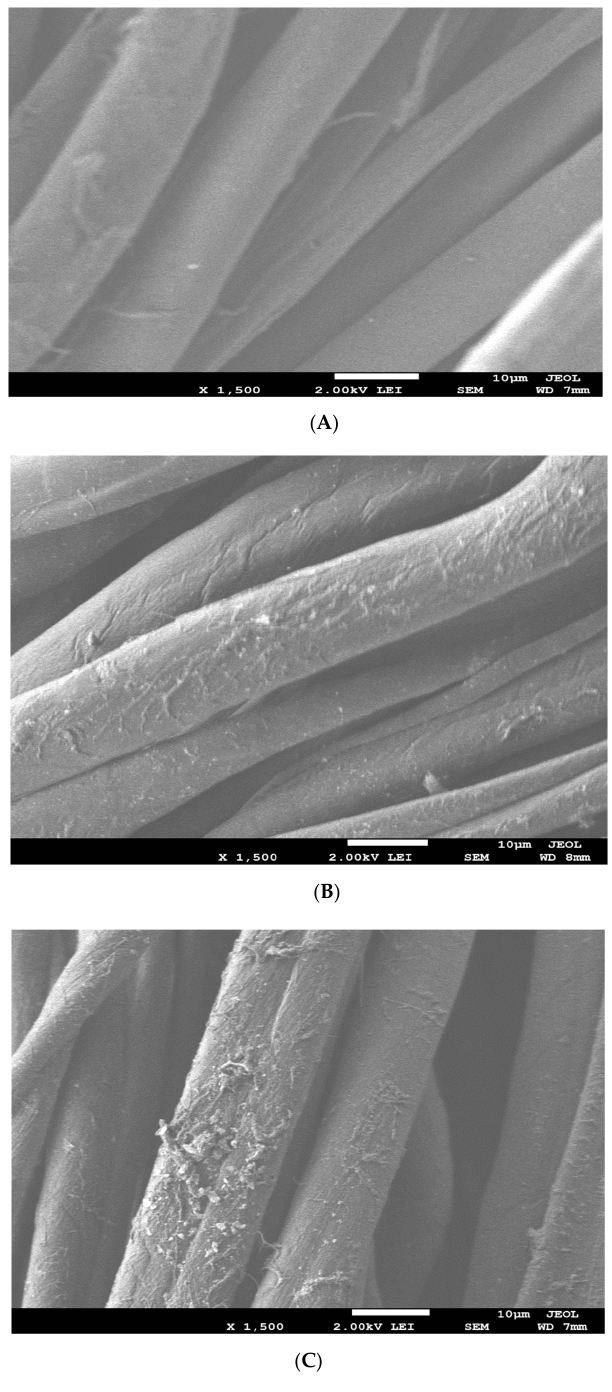
Figure 2. SEM images of CF ( A ), 6 mL sample AgNp-CF ( B ), catalase immobilized onto B sample ( C ).